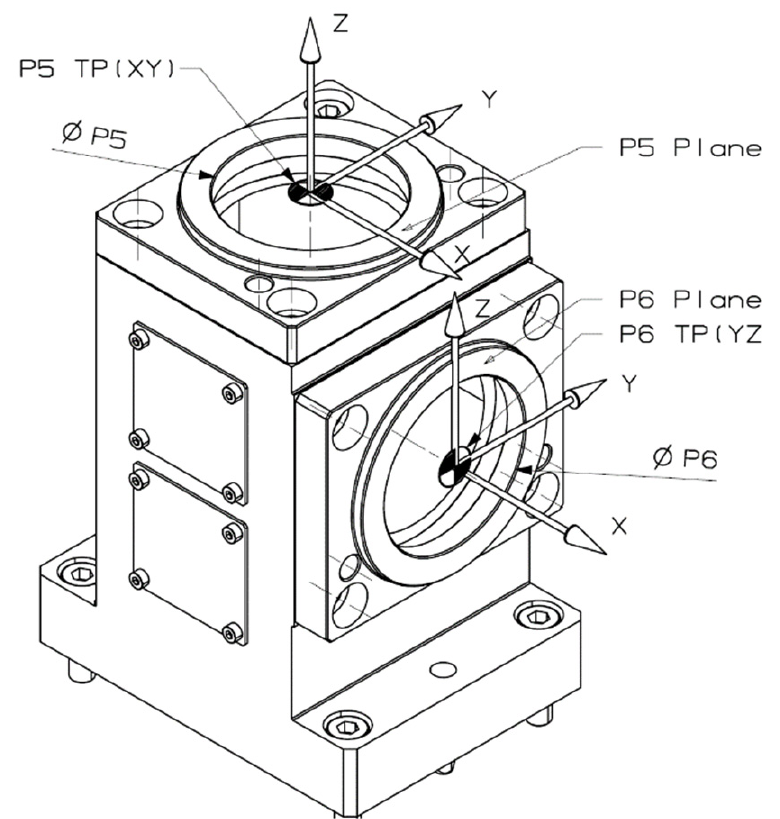
Figure 7. The artifact concept for the TTP system performance test—custom artifact for 5-axis MT with tilting head: B 0° P5 position, G54.1P290 working base; P5 surface, plane A; P5 DIA., bore B; B 90° P6 position, G54.1P291 working base; P6 surface, plane C; P5 DIA., bore D.